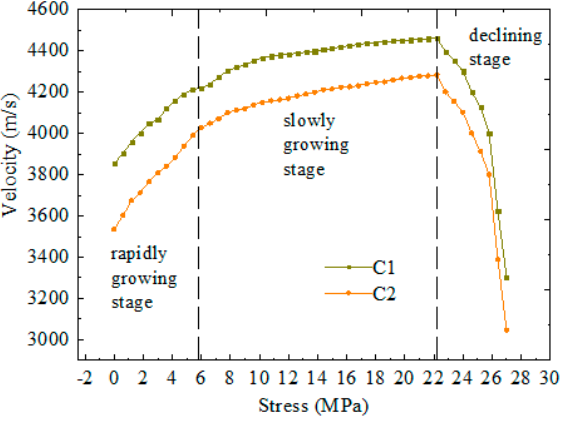
Figure 9. Velocity development with different stress.